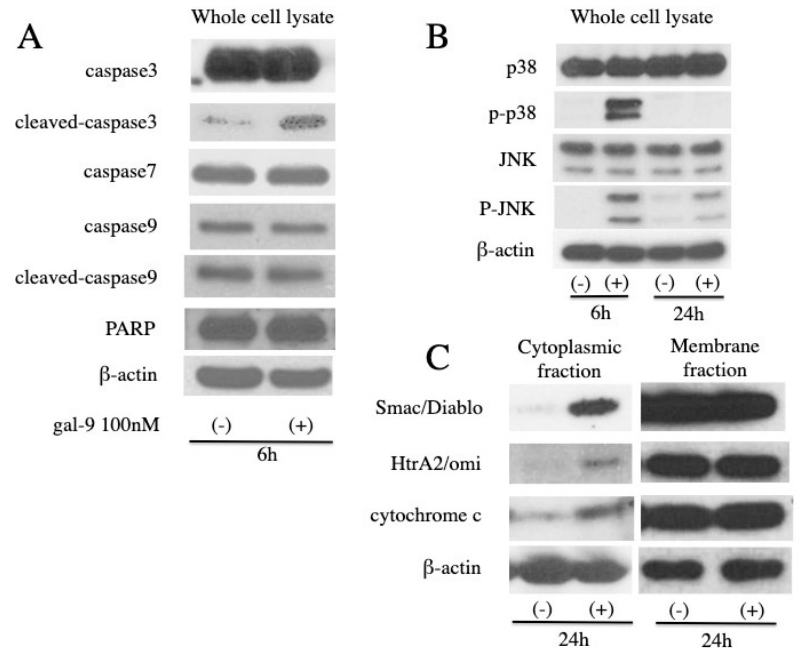
Figure 3. Western blotting analysis of apoptosis-related regulators. The lysate of KYSE-150 cells treated with or without 100 nM Gal-9 was analyzed by Western blotting. ( A ) Cleaved caspase-3 level was increased at 6 h after Gal-9 treatment; ( B ) No difference was observed in the total amount of c-Jun NH 2 -terminal kinase (JNK) and p38. Phospho-SAPK/JNK (p-JNK) increased in 6 h, while phospho-p38 MAPK (p-p38) increased in 6 and 24 h ( B ); ( C ) An increase in Smac, HtrA2, and cytochrome c level was observed in the cytoplasmic fraction, but no change in the levels of these proteins was observed in the membrane fraction containing mitochondria.